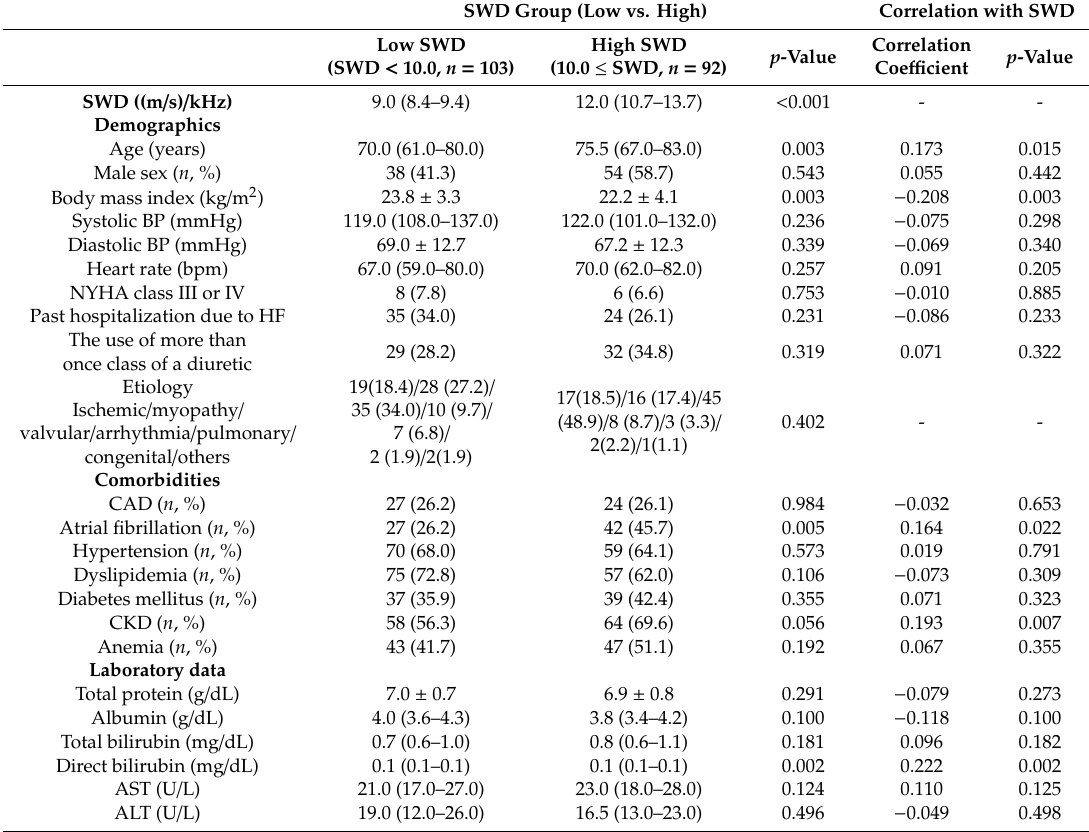
Table 1. Comparisons of patient characteristics ( n = 195). SWD Group (Low vs.